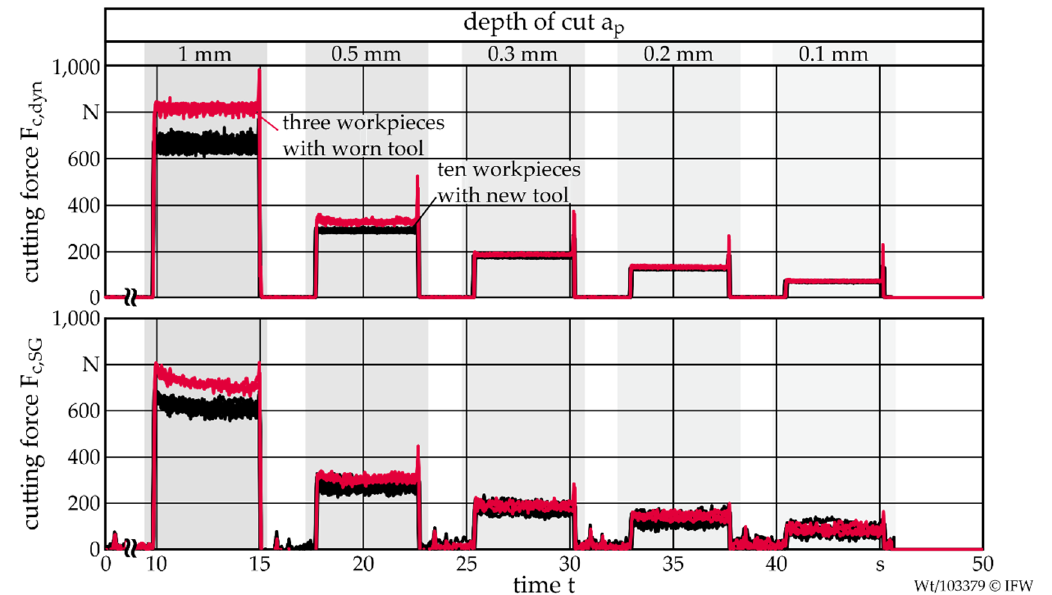
Figure 5. Cutting force characteristics for new and worn tool for different depths of cut.